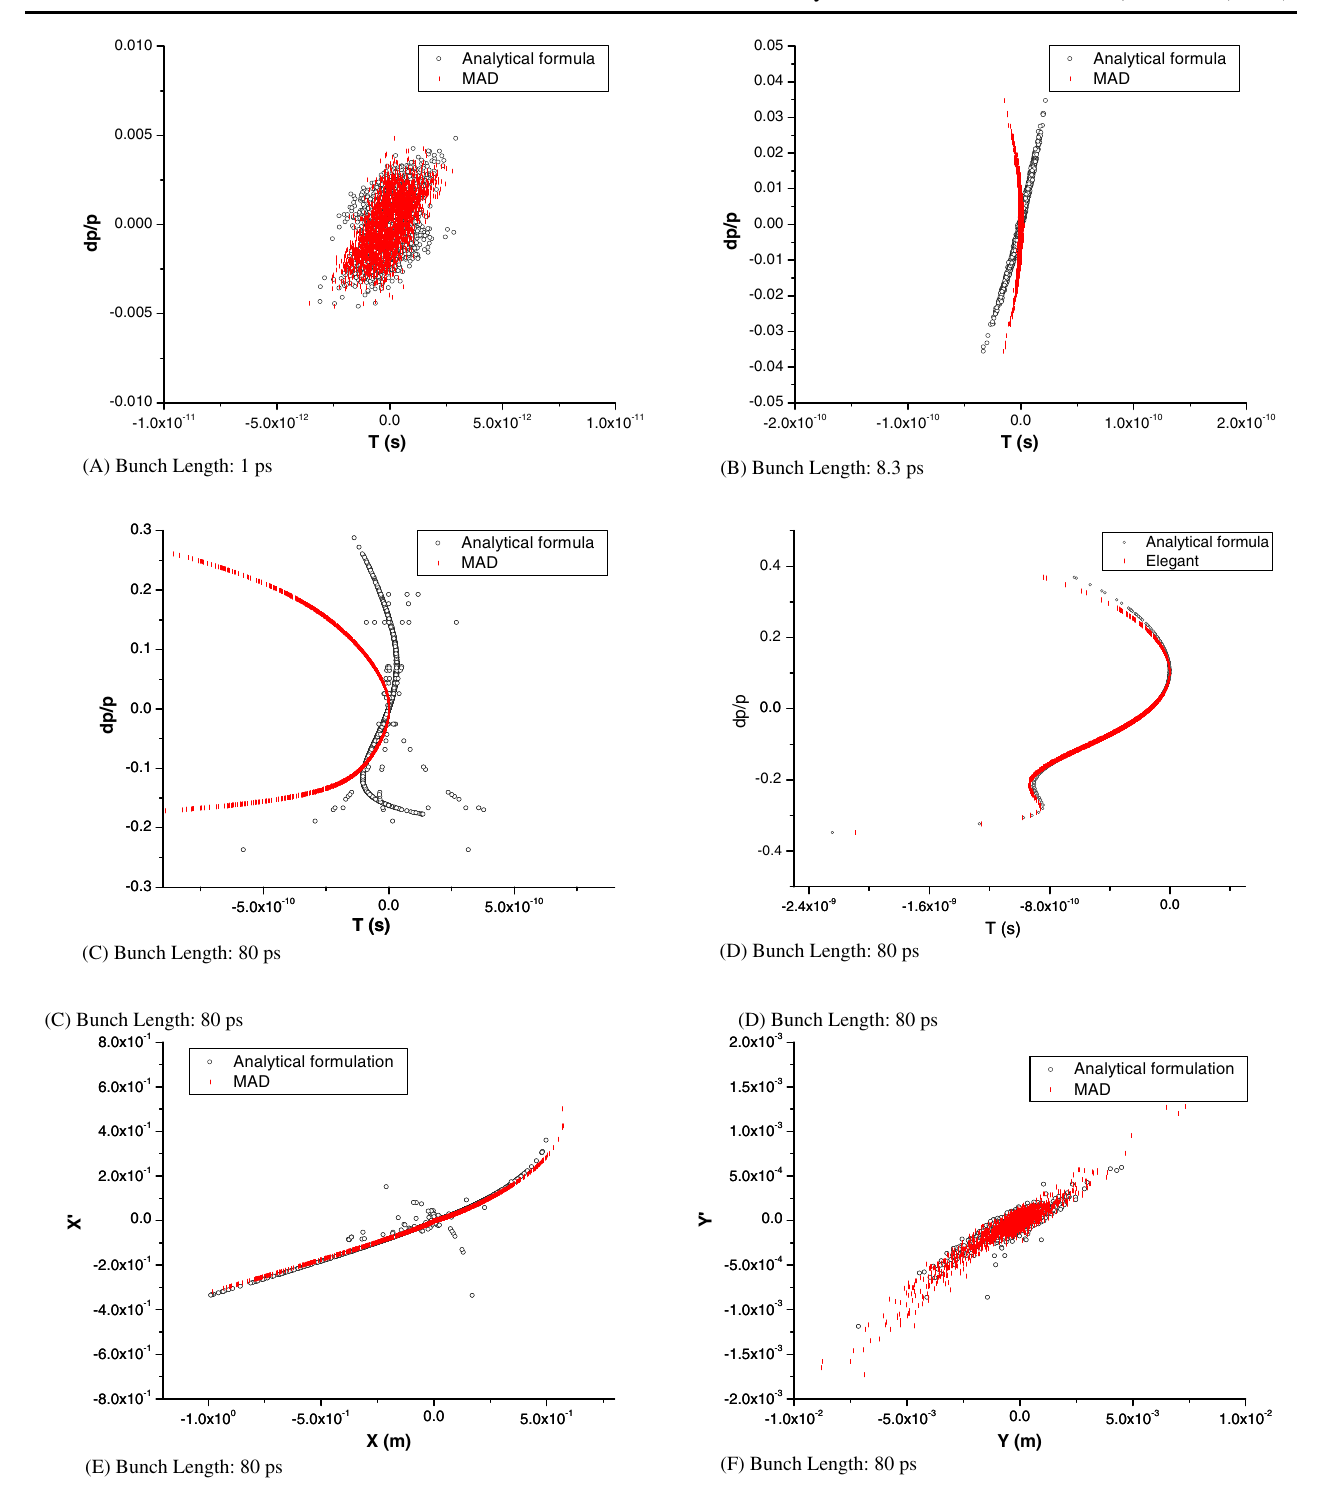
FIG. 11. Phase space distribution of beam after bunch compressor (analytical and numerical